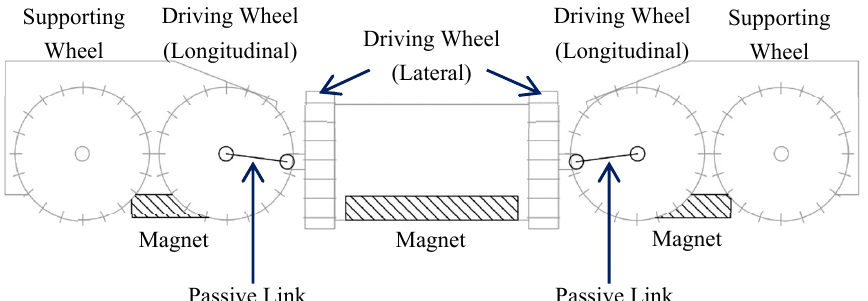
Figure 2. The side view of the robot configuration with the passive linkage mechanisms.